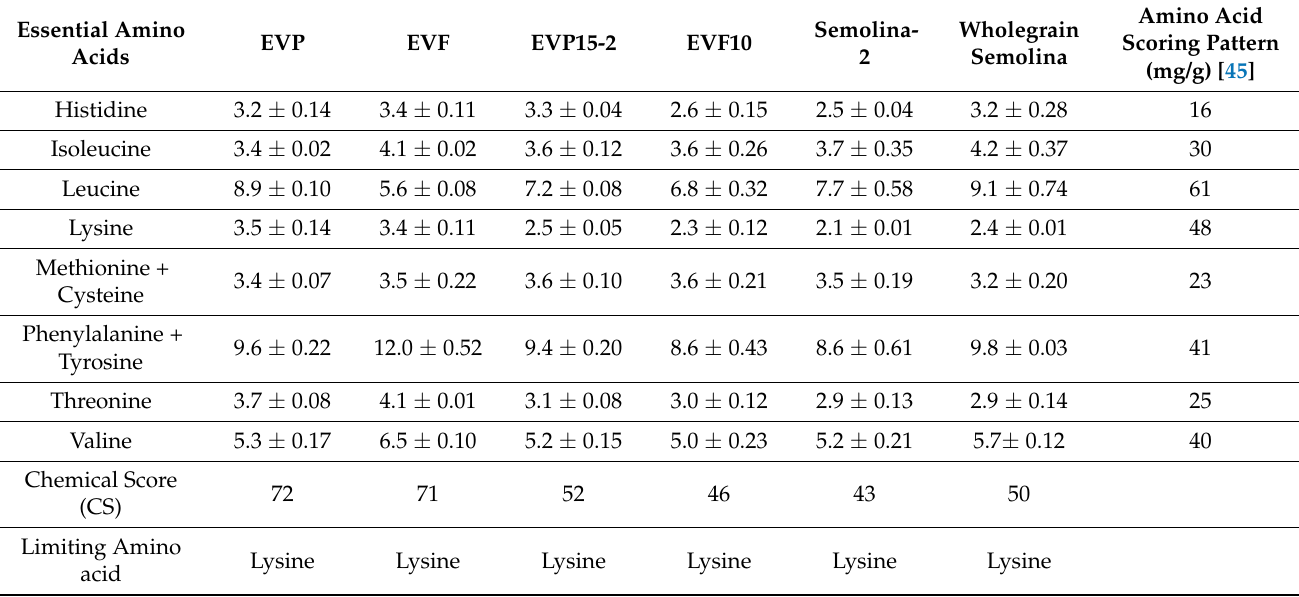
Table 6. Amino acid (g/100 g protein), chemical score (CS) and limiting amino acid of BSG ingredients and